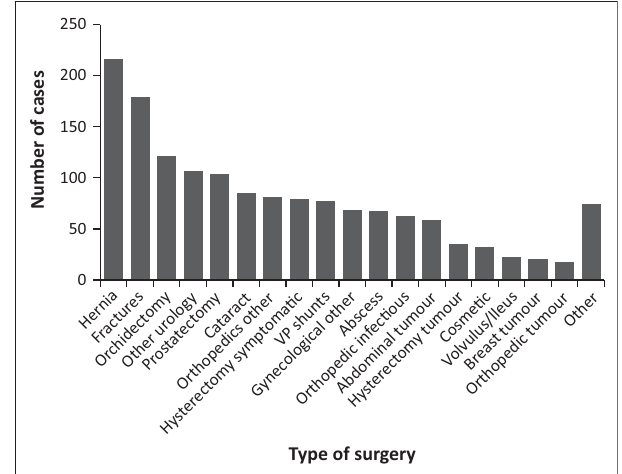
FIGURE 1: Type of surgery.